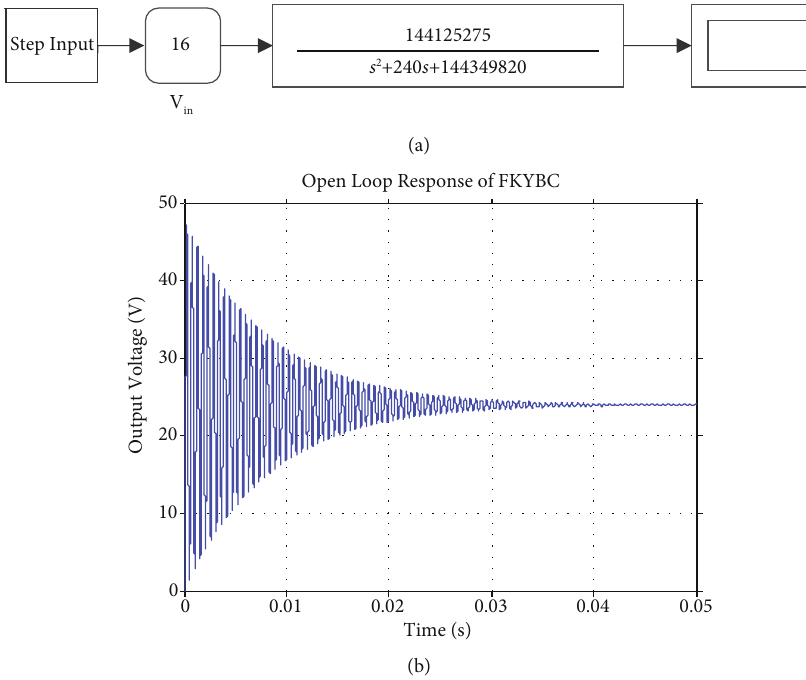
Figure 2: (a) MATLAB/Simulink model of FKYBC and (b) simulated open-loop response of FKYBC.